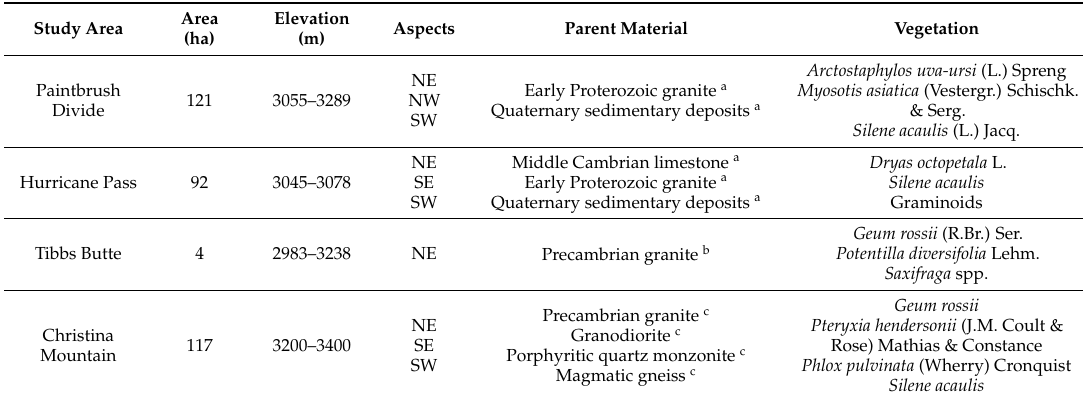
Figure 2. Study area geographic locations. The geographic location of study areas within the GYE. The black line traces the Continental Divide. Map courtesy of Google [44]. Figure created using the ggmap (version 2.6.1, Waco, TX, USA.) [45], ggplot2 (version 3.0.0, Houston, TX, USA.) [46], and ggrepel Table 1. Study area characteristics.